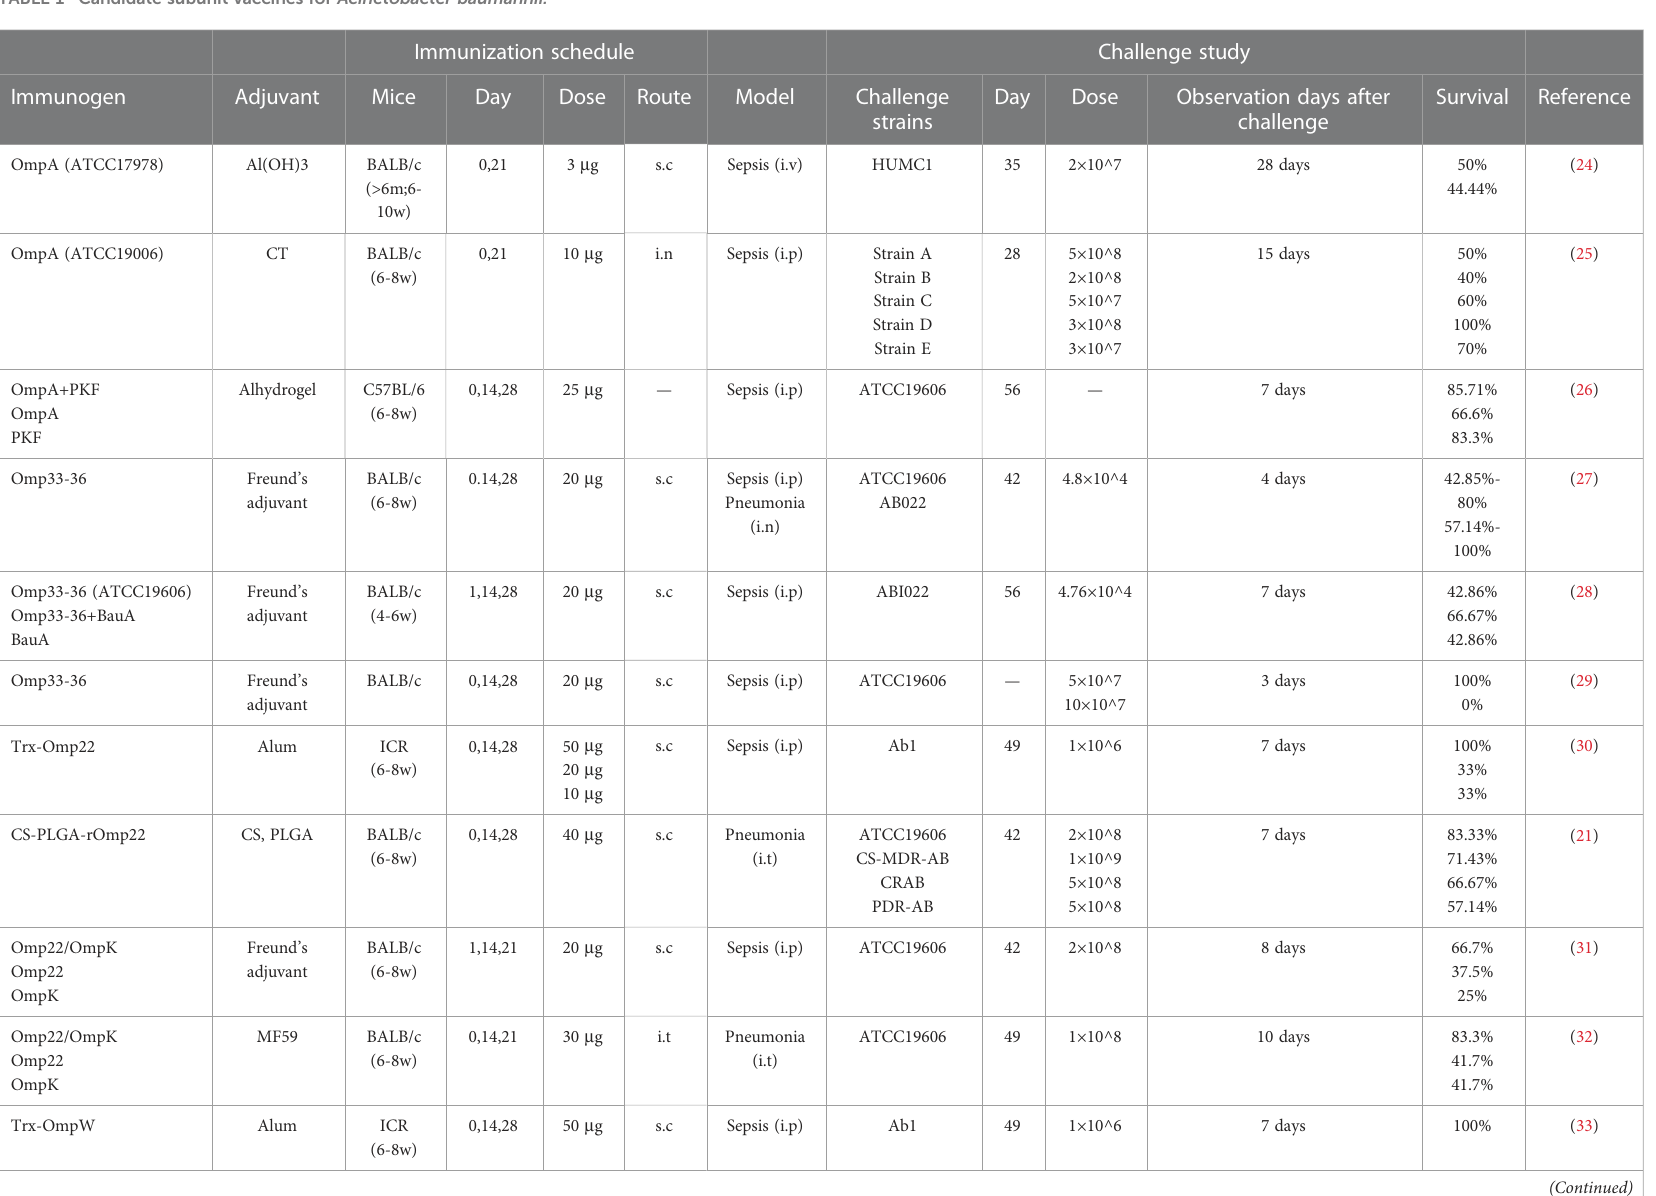
TABLE 1 Candidate subunit vaccines for Acinetobacter